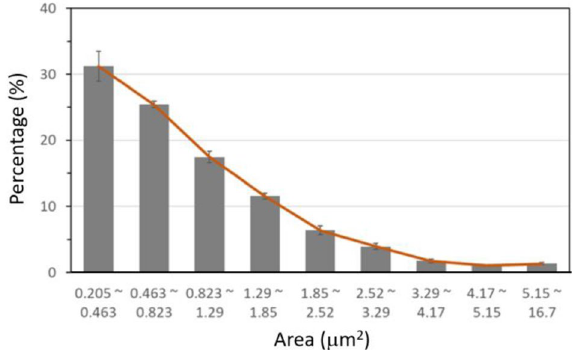
Figure 3. An approximate size-distribution function of γ-H2AX foci expressed in BEAS-2B cells 1 h after X-ray exposure. The distribution of discrete size groups (grey bars) were quoted from Lee et al. 15 .